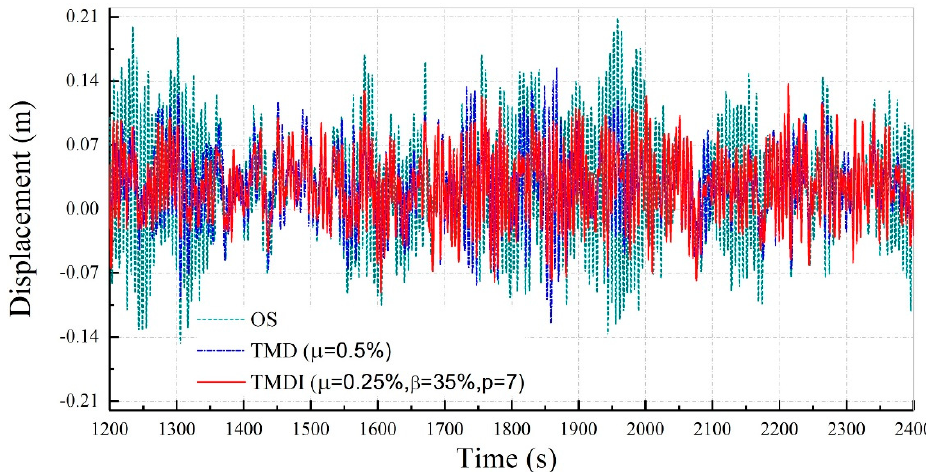
Figure 13. Time histories of displacement at the 69th story along the x -axis corresponding to 90° wind direction.